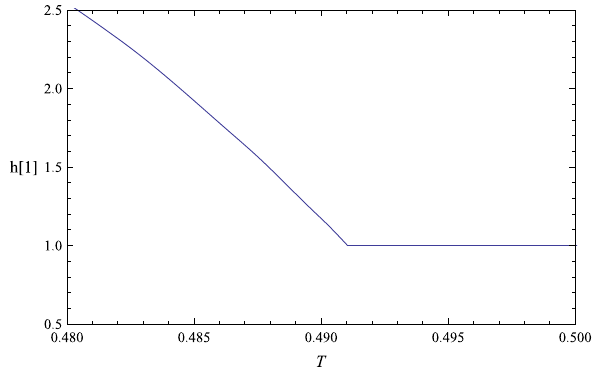
Fig. 5 We show behaviors of h ( 1 ) as a function of the temperature T with q = 100, m 2 = 0 and μ = 0 . 15